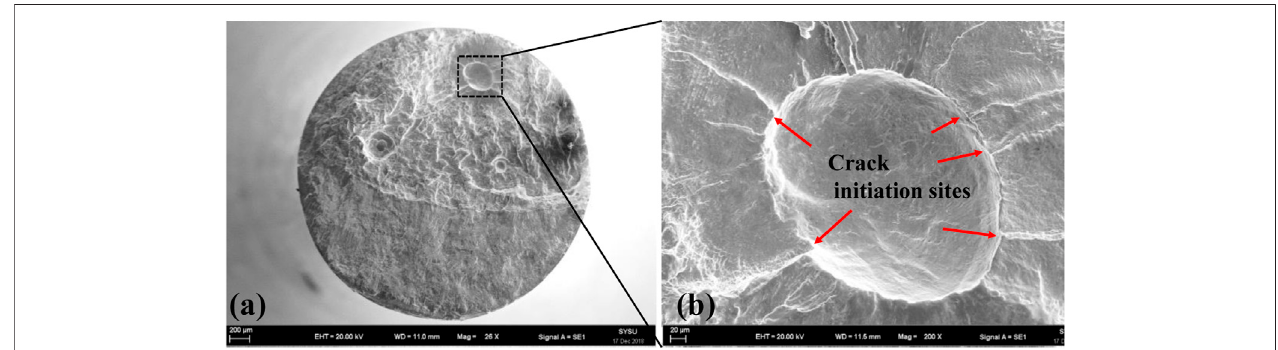
FIGURE 6 | Fracture surface of the specimen (LBW) tested at 380 MPa failed at 7.15 × 10 5 cycles. (A) overview of the fracture surface and (B) enlargement of the marked rectangle in (A) .